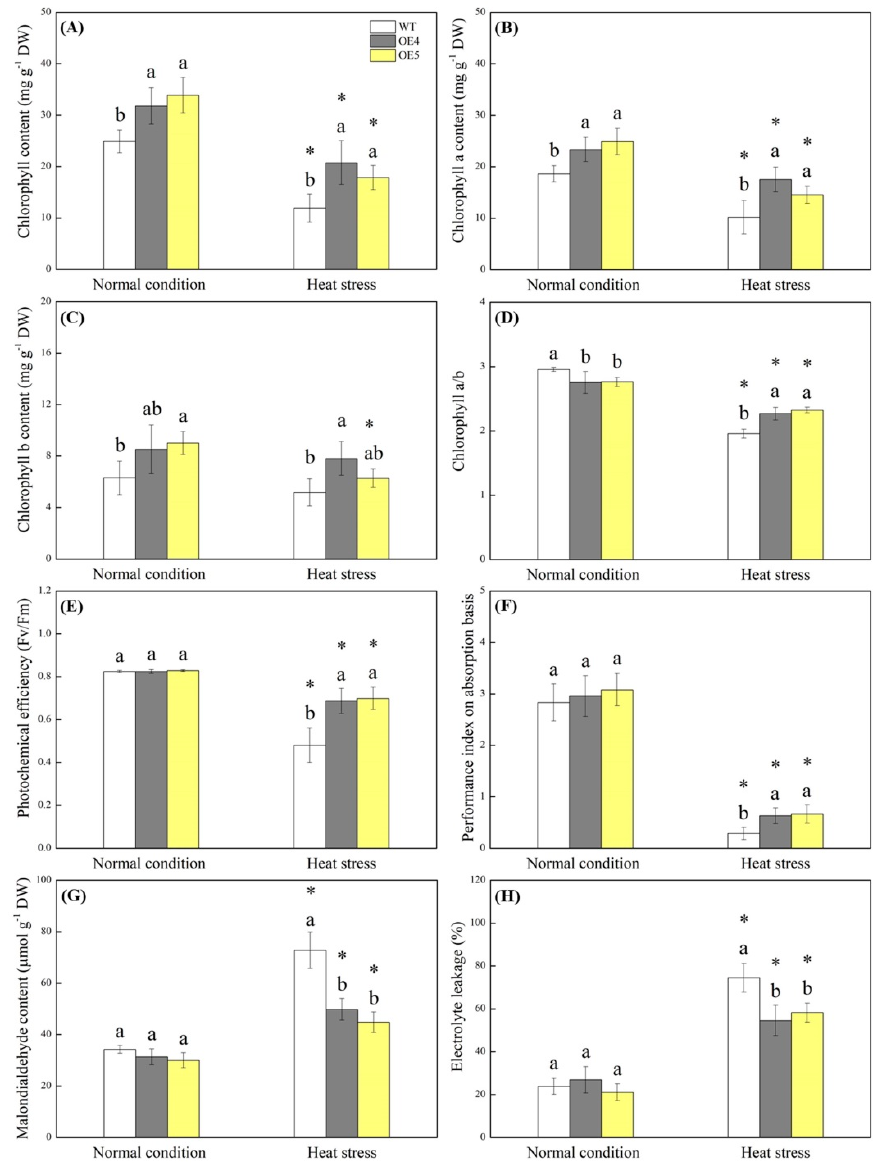
Figure 4. Changes in ( A ) total chlorophyll content, ( B ) chlorophyll a content, ( C ) chlorophyll b content, ( D ) chlorophyll a/b ratio, ( E ) photochemical efficiency, ( F ) performance index on absorption basis, ( G ) malondialdehyde content, and ( H ) electrolyte leakage of wild type (WT) and transgenic Arabidopsis thaliana overexpressing the TrSAMS (OE4 and OE5) involved in spermidine biosynthesis under normal condition and heat stress. Vertical bars indicate ± SE of mean ( n = 4). Different letters above column indicate significant differences ( p ≤ 0.05) among treatments under a particular condition (normal condition or heat stress). The asterisk “*” indicates significant differences ( p ≤ 0.05) for a particular material (WT, OE4, or OE5) for comparison between normal condition and heat stress.